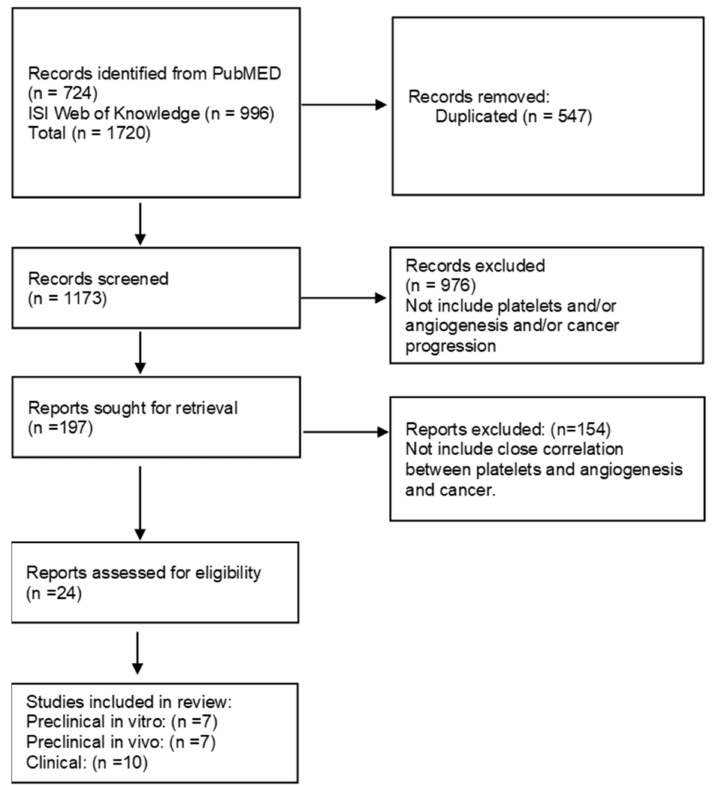
Figure 2. Flow diagram of screened